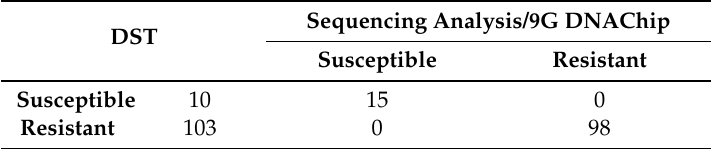
Table 1. Comparison of outcomes of the drug susceptibility testing (DST), sequencing analysis, and 9G DNAChip.